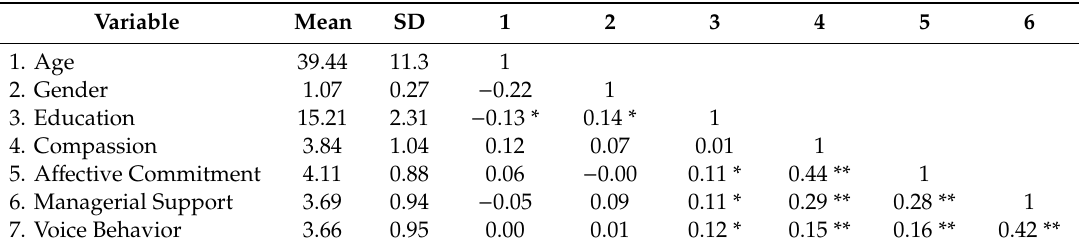
Table 3. Correlation analysis.